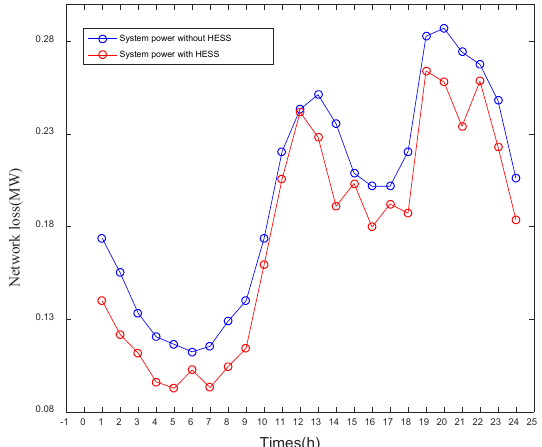
Figure 9. Network loss comparison after adding HESS to ADN.